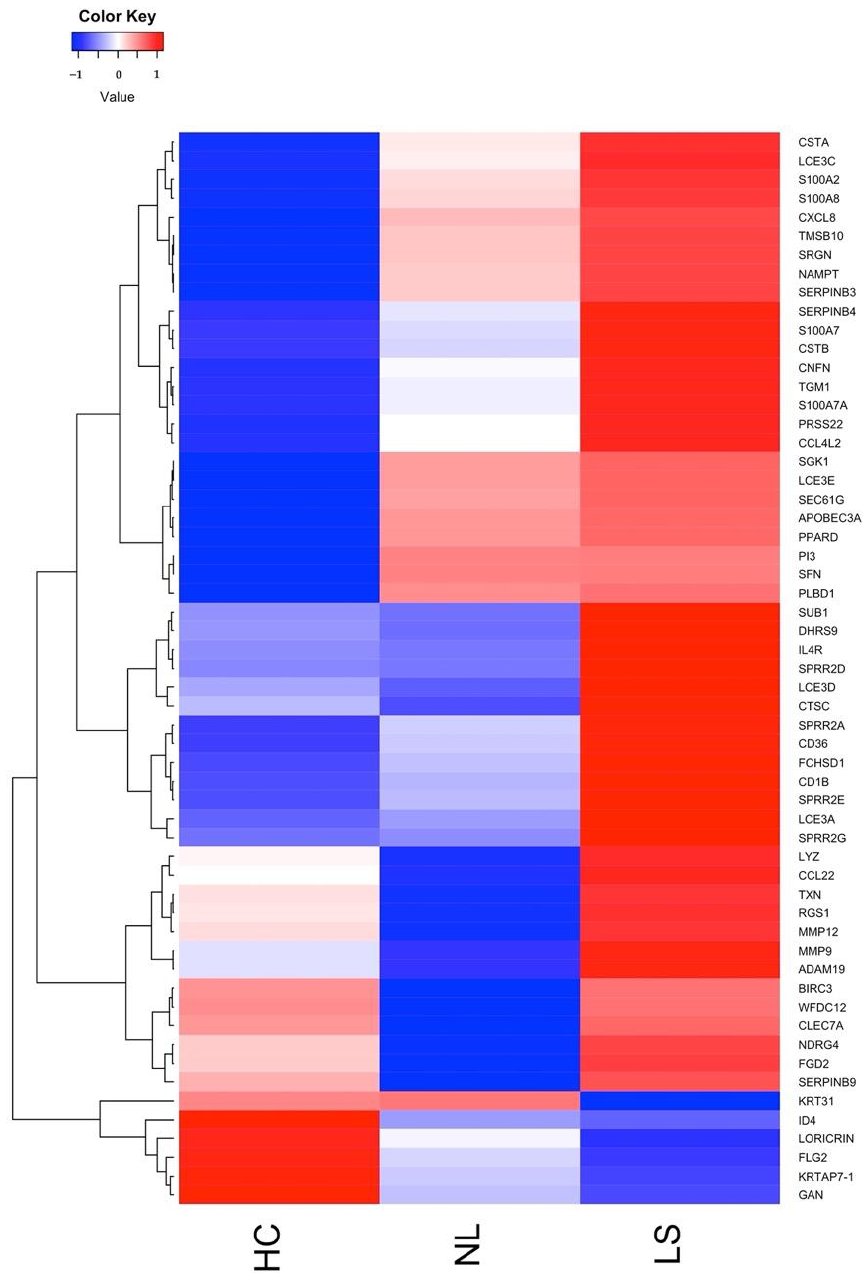
Figure 4. Heatmap and one-way unsupervised hierarchical clustering showing selected AD signature genes obtained from tape-stripped skin samples. Each column represents the Z-scaled group mean gene expression for HC, NL, and LS skin.